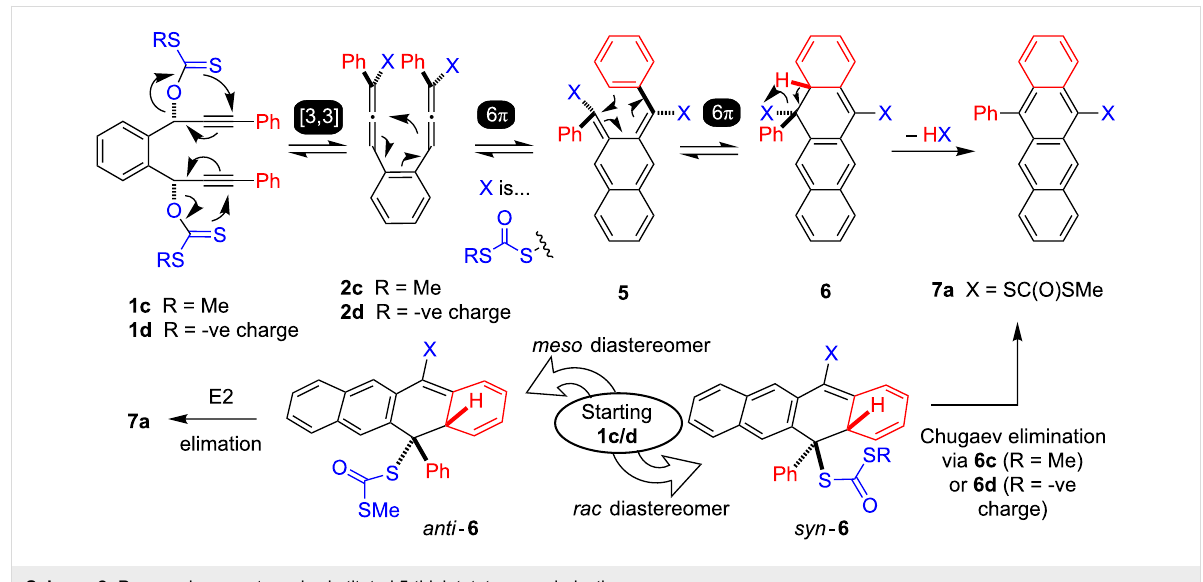
Scheme 2: Proposed access to aryl substituted 5-thiolatotetracene